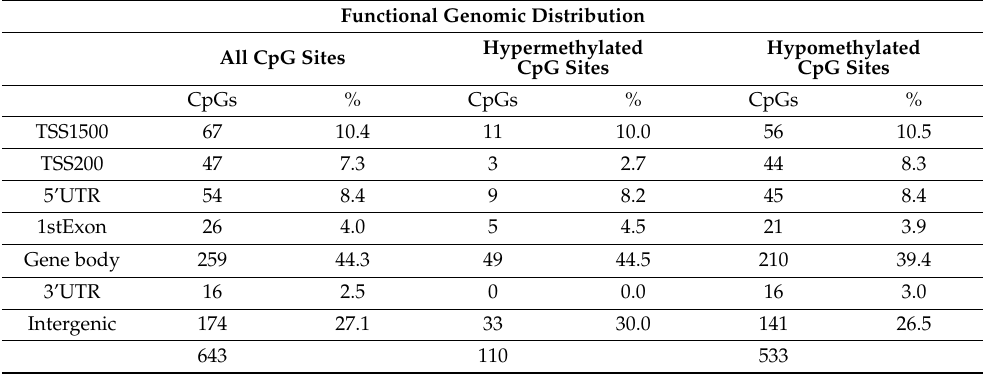
Table 2. Comparison of statistically significant CpG site methylation ( ∆ β > 0.1 and p < 0.05) between ischaemic cardiomyopathy patients and control